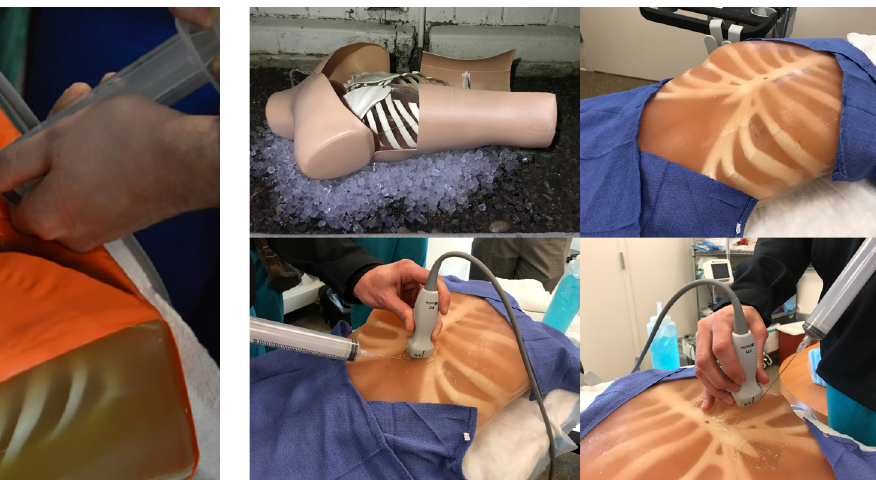
Figure 2. Modified ultrasound-guided pericardiocentesis trainer using a plastic dress form torso turned upside down to act as a